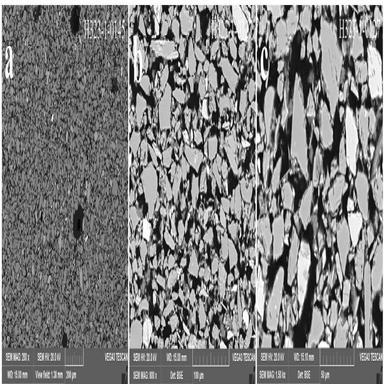
The BSE micrographs of the mould samples with Texture A.